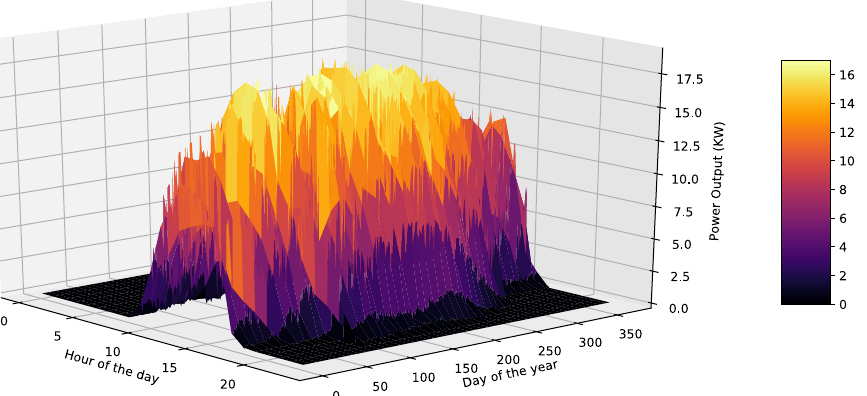
Figure 4. The power output expected under clear sky conditions for the base PV as a function of the hour of the day (ranging between 0 and 23) and the day of the year (ranging between 0 and 255).